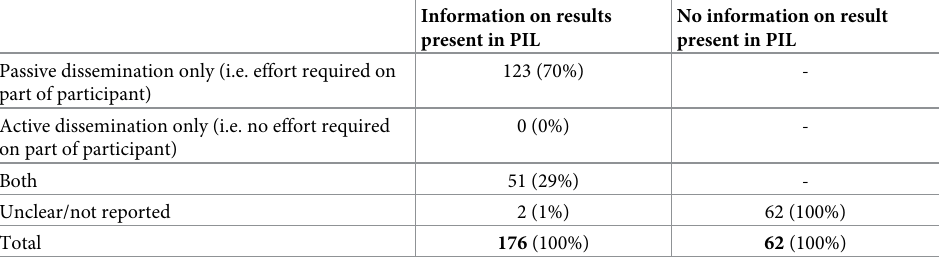
Table 2. Inclusion of information on trial results summaries in PILs and means of